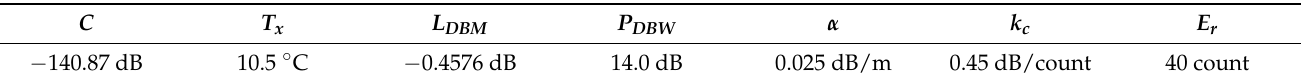
Table 1. Parameters for equipment